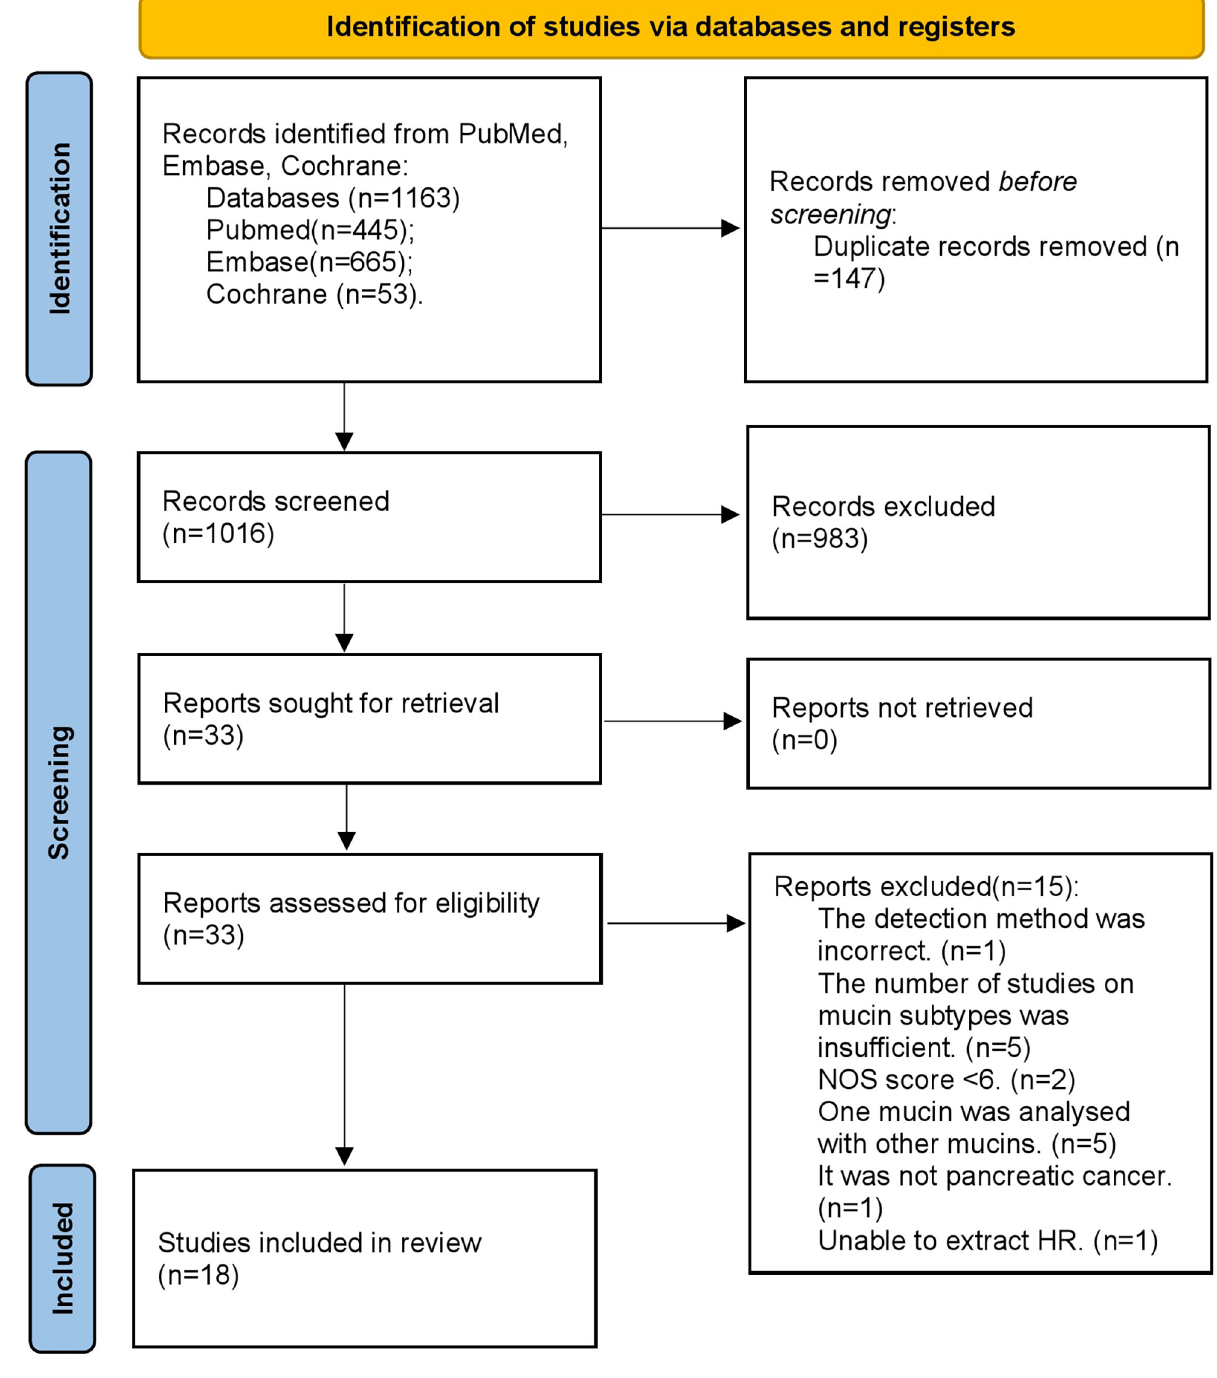
Fig 1. PRISMA flow chart for the identification of the included studies.